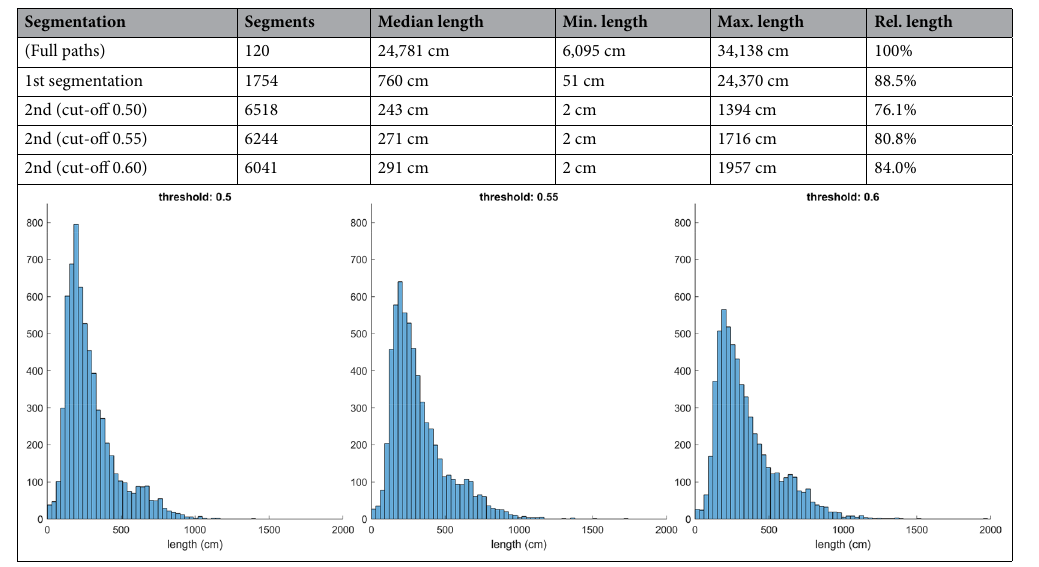
Table 1. Segmentation of trajectories statistics. All lengths are measured in the arena (rotating) reference frame. The last column shows the total length of the resulting segments compared to the input (full paths or segments), i.e., without the short segments or subsegments that were discarded. The figure below the table shows the length distributions of the subsegments for the 2nd stage segmentations.